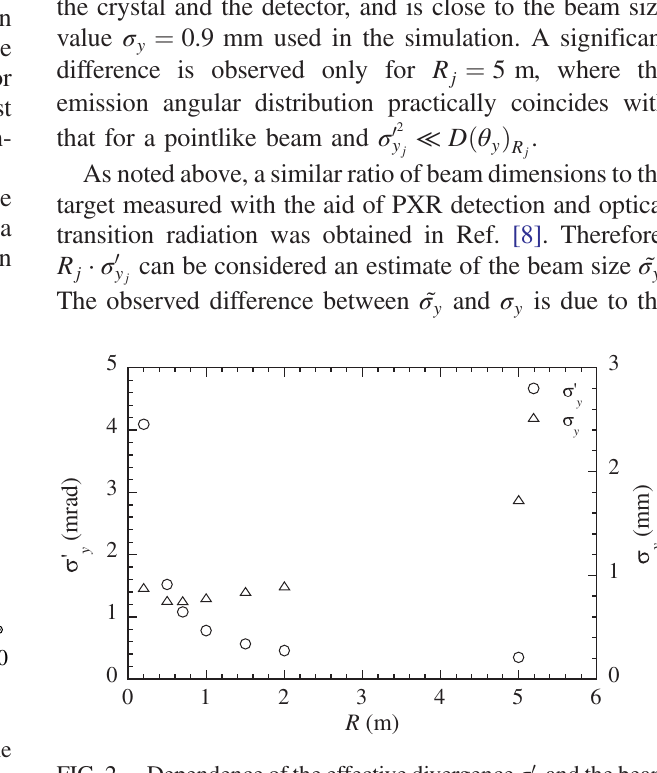
FIG. 2. Dependence of the effective divergence σ 0 y and the beam size estimate σ y on the distance between the crystal and the ¼ 32 . 2 °. detector for the conditions of the experiment D